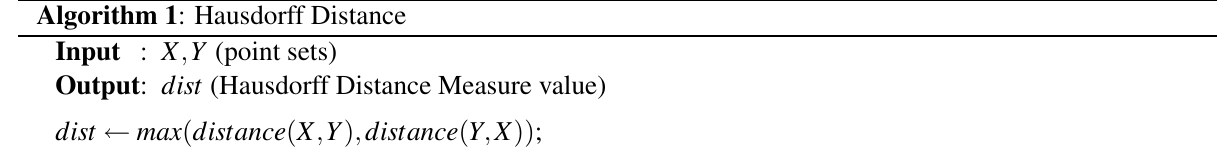
Fig. 10. B & L images NM Measurements Comparison